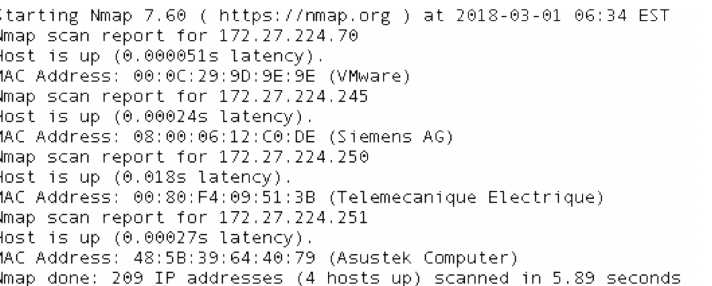
Figure 16. NMAP scan results.